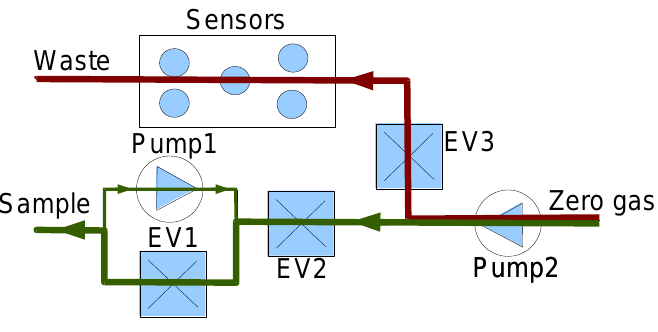
Figure 4. Gases flow at the cleaning1 (red) and cleaning2 (green)